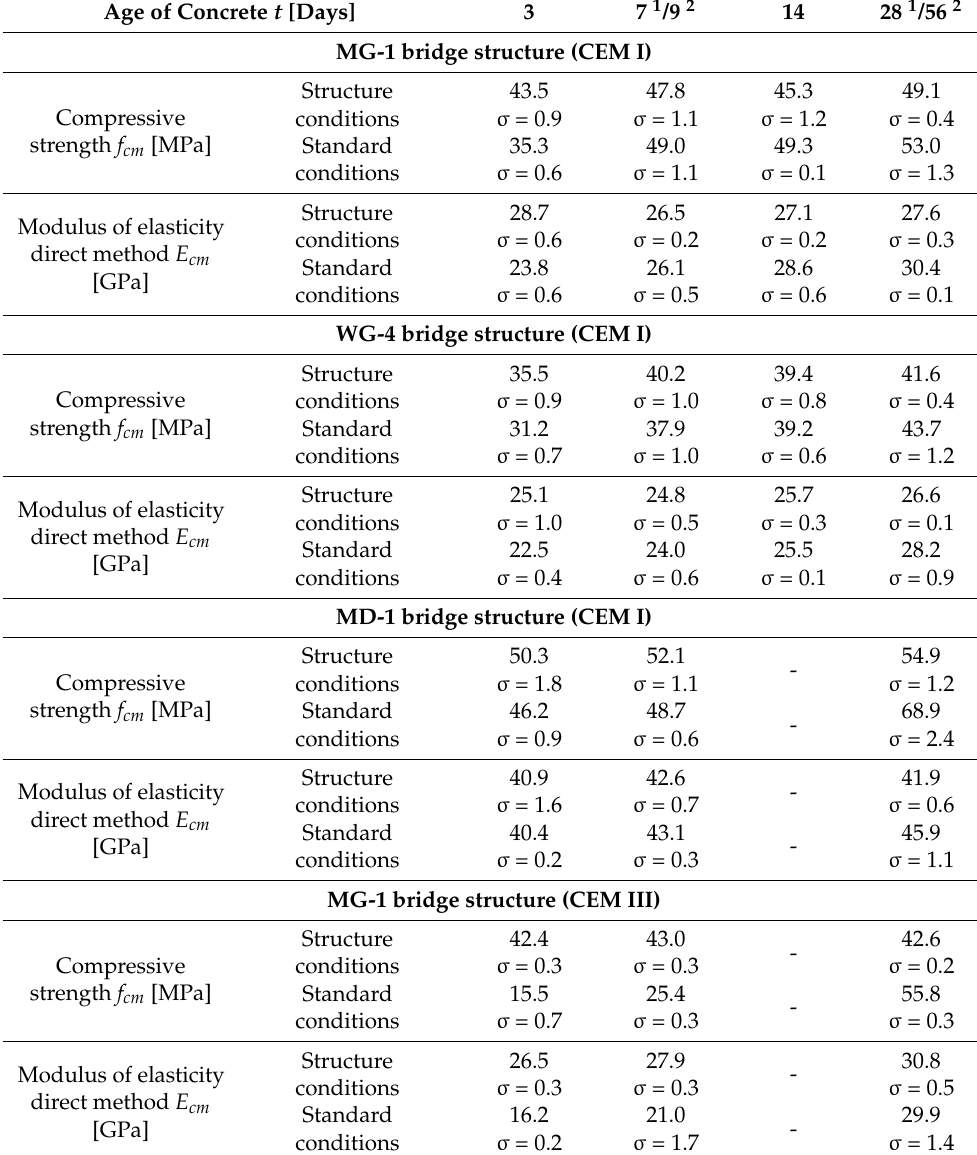
Table 3. Summary of laboratory test results–preliminary